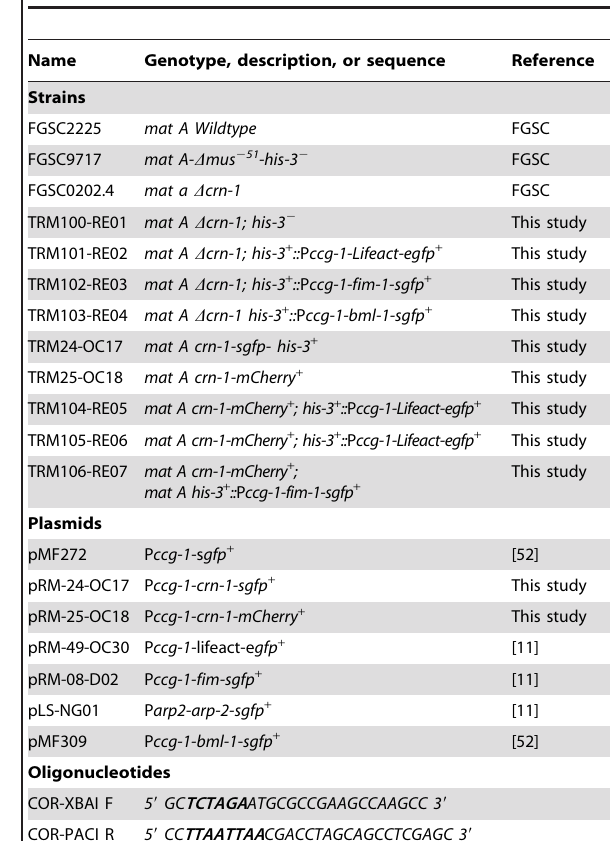
Table 2. Materials used. N. crassa strains, plasmids and